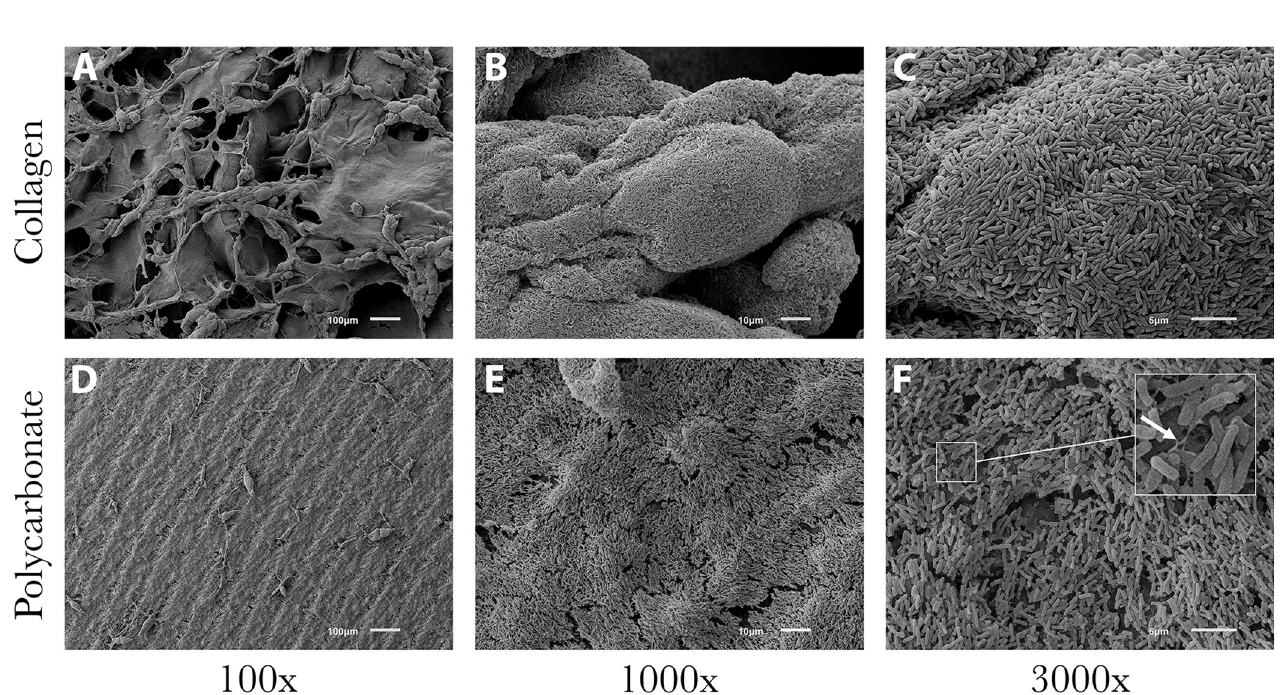
Fig 3. Representative SEM images of P . aeruginosa ATCC 27853 biofilm formation on both material types. (A-C) Surface of a collagen coupon that had biofilm coverage. Biofilm structure conformed to the polymeric collagen network. As noted in Fig 2, deep valleys and ravines were consistent throughout the amorphous structure. (D-F) Surface of a polycarbonate coupon on which biofilms of P . aeruginosa ATCC 27853 grew. Biofilm structure was estimated to be greater than 20 cell layers thick. Growth followed the contour of the surface, even displaying the coupon machine marks (100x). Arrow (panel F) indicates extracellular matrix components that were